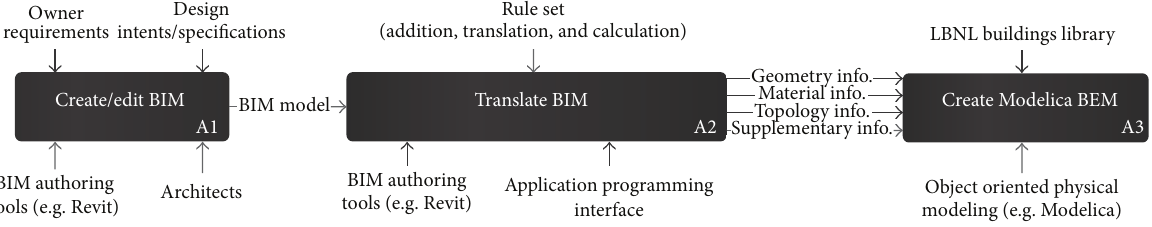
Figure 2: A process model of BIM-to- ModelicaBEM translation using IDEF0.